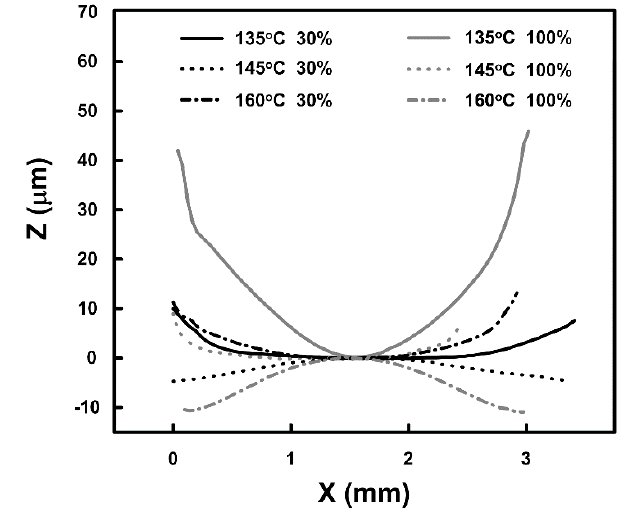
Figure 17. Comparison of typical cross-sections in samples programmed at 135 °C and above.